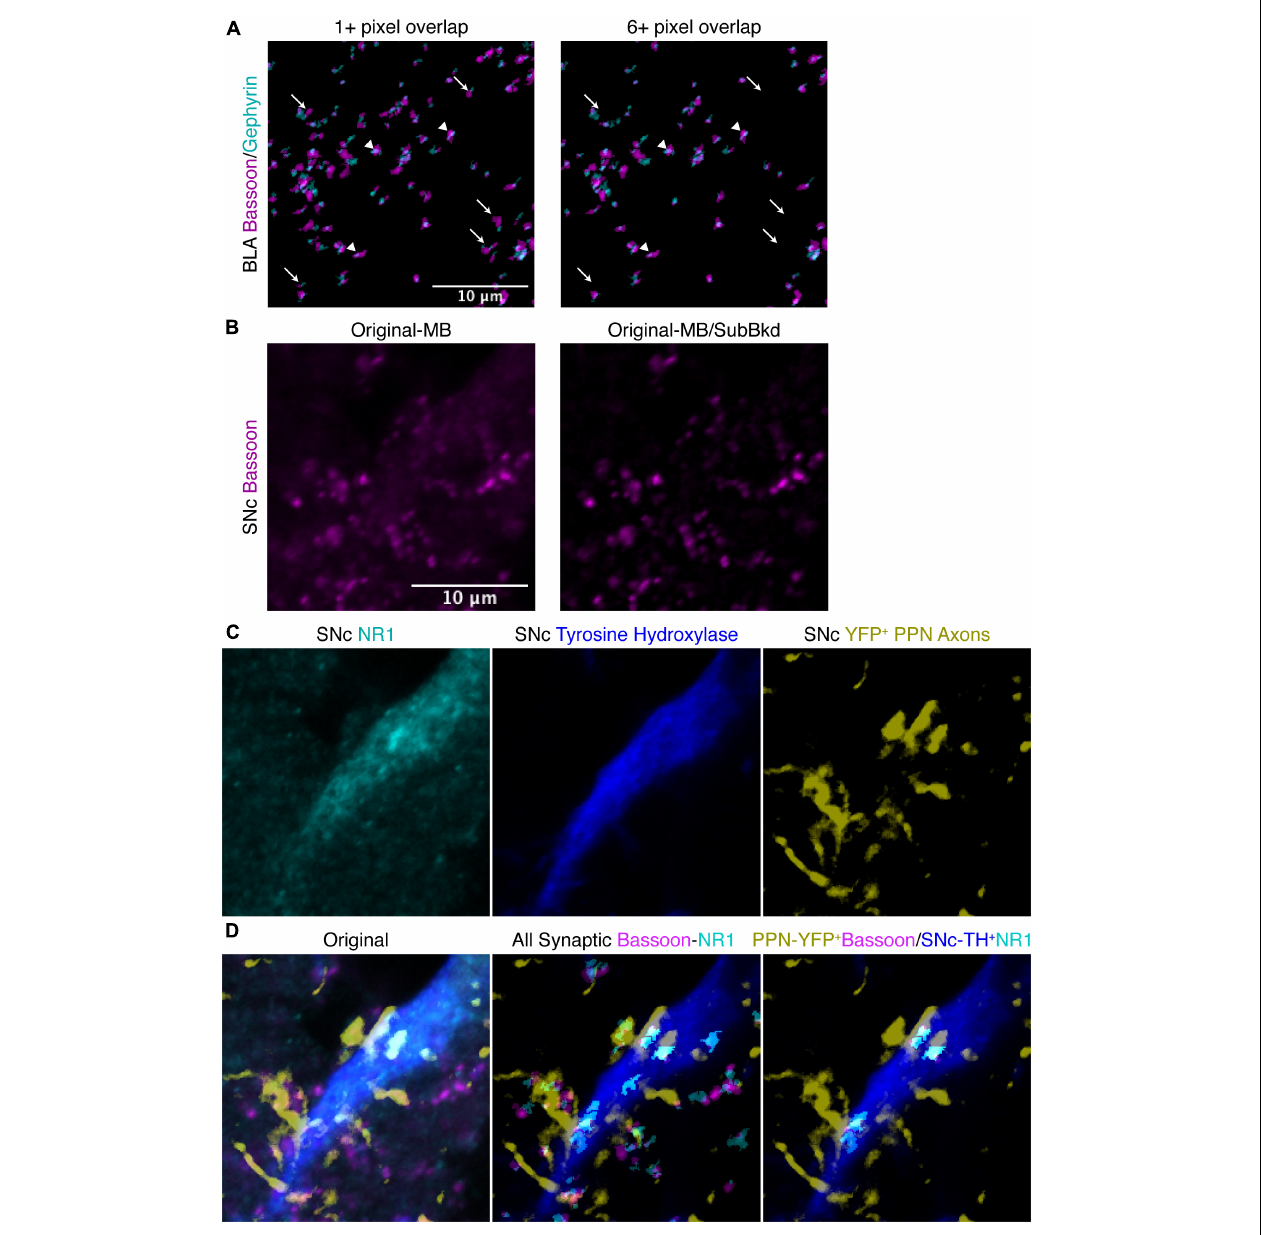
FIGURE 8 | Additional features of SynapseJ allow for identification of synaptic puncta with increased discrimination. (A) Specifying a minimum number of pixel overlap of 6 or more, removes some overlapping puncta (arrow), while other puncta remain (arrowhead), in this image of anti-bassoon (magenta) and anti-gephyrin (cyan) from BLA. Scale bar is 10 µ m for the panels in panel (A) . (B) In this image of anti-bassoon from SNc, applying the subtract background with a radius of 10 efficiently removed background staining while not modifying the brightly labeled puncta. Scale bar is 10 µ m, and applies to panels in panels (B–D) . (C) Original immunostaining for NR1 (cyan), tyrosine hydroxylase (blue) and YFP in SNc from the same area as the bassoon in panel (B) . (D) The merge images for the original staining (left), identified overlapping anti-bassoon/anti-gephyrin puncta from the entire panel (center), and identified overlapping YFP + PPN axonal anti-bassoon puncta with TH + SNc neuronal anti-NR1 puncta (right) demonstrate the utility of SynapseJ in identifying neuronal sub-class limited expression of synaptic markers.